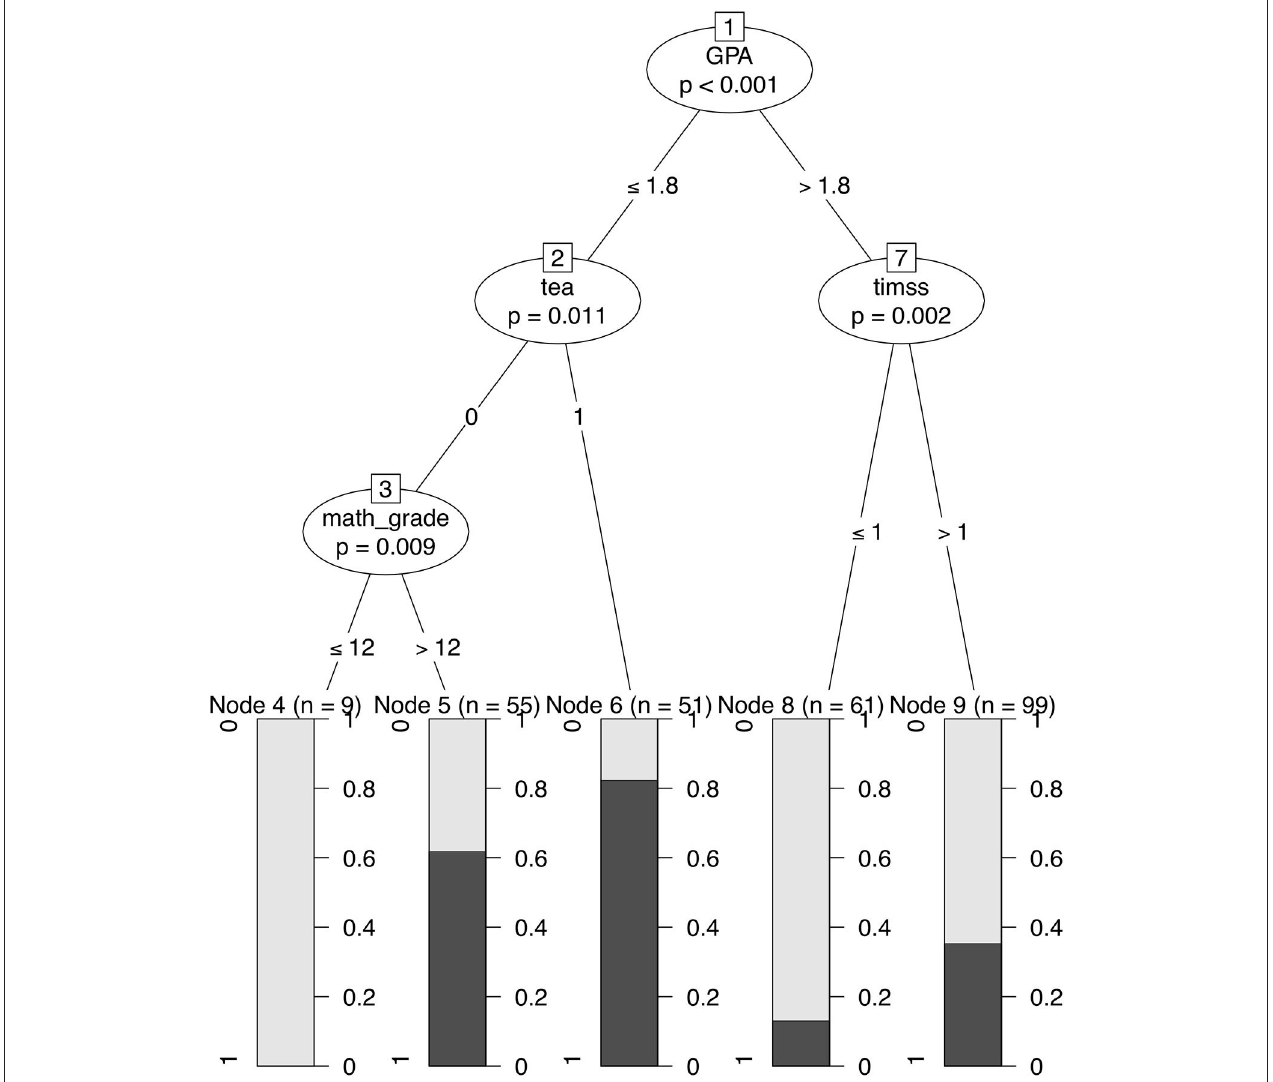
FIGURE 1 | Conditional inference tree with the selected features and splits. The figure shows the split-points within the features used for splits. In the terminal nodes 4–6, 8, 9 the frequencies of the target variable “pass” is shown. GPA, grade point average in the final exam in school; tea, teacher candidate or not; timss, sum score of the TIMSS items; math_grade, math grade in the final exam in